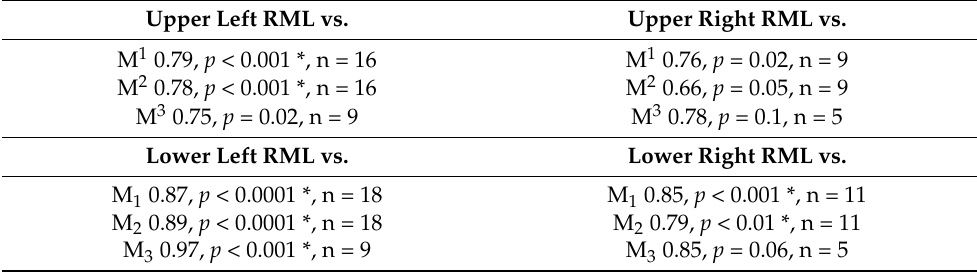
Table 7. Pearson’s Correlation Coefficient (r) of retromolar length (RML) with molar lengths (M1, M2, M3), showing strong and significant correlations (*) for most but not all molars all four quadrants among upper and lower jaws. In all four quadrants, significance of correlation was lowest for M3 with RML. There is no clear pattern where one molar type correlates most strongly with RML. Upper Left RML vs. Upper Right RML vs.